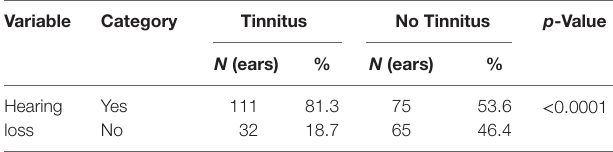
Table 3 | Prevalence of hearing loss among tinnitus and non-tinnitus patients ( χ 2 test).